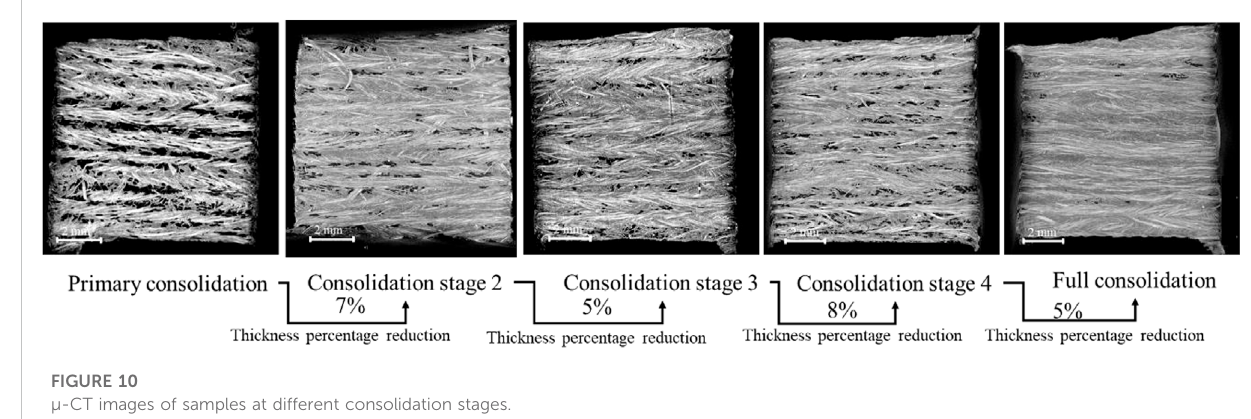
FIGURE 10 µ-CT images of samples at different consolidation stages.